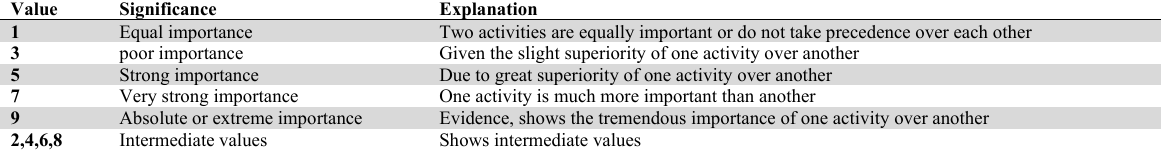
Relative significance (weight) scales for pair wise